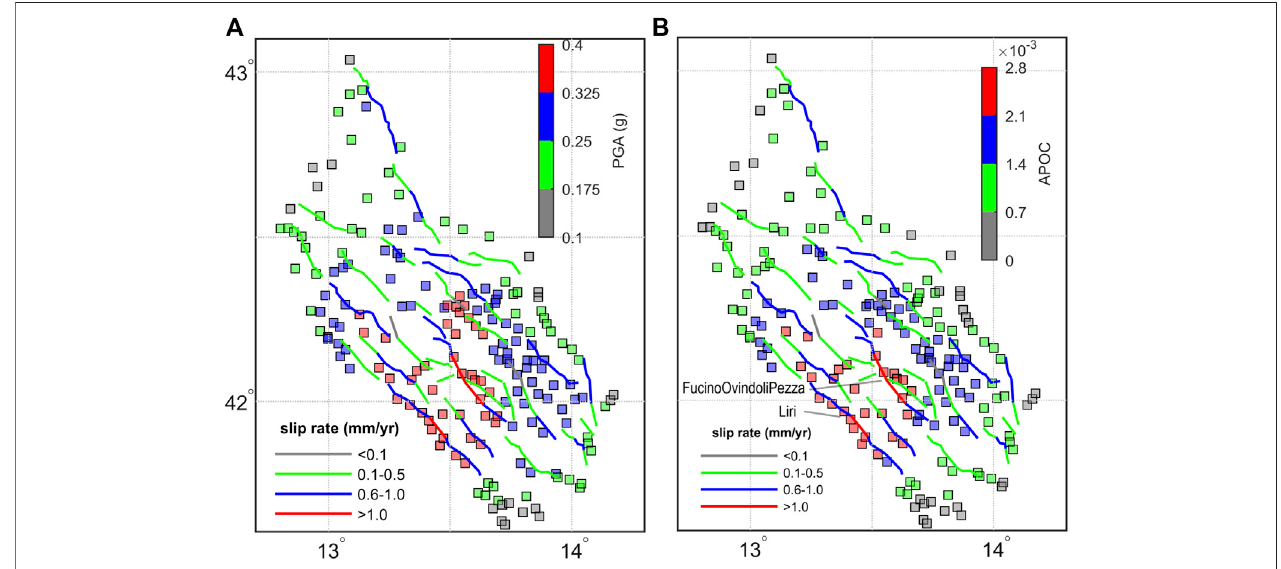
FIGURE7 | Fault-based seismic hazard and typological riskat somelocalities (indicated by fi lledsquares) colorcoded according to PGAhazard levels (A) and risk classes (B) .ResultsbasedontheA1B1C1MainFaultoptioncon fi gurationoftheFault2SHACADandconsideringonlymeanparametersforthesliprate,theb-valueand the magnitude scaling relationship. (A) PGA with an annual probability of exceedance of 0.0021 (corresponding to a return period of475 years) based on the Bindi et al. 2011 GMPE using hard rock soil coef fi cients. (B) Annual Probability Of Collapse (APOC) for a L-type-pre1919 building, based on the Rosti et al. (2020) taxonomy. MF-section are color-coded according to their slip rate